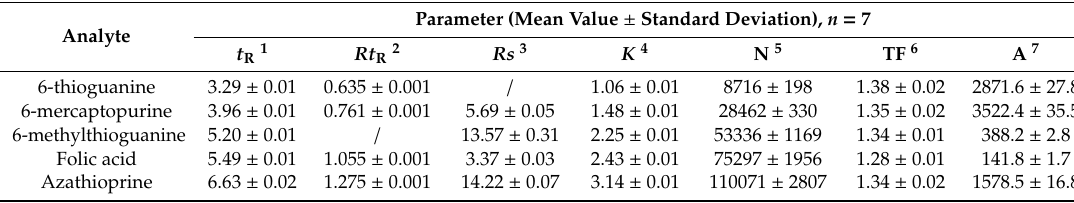
Table 3. System suitability